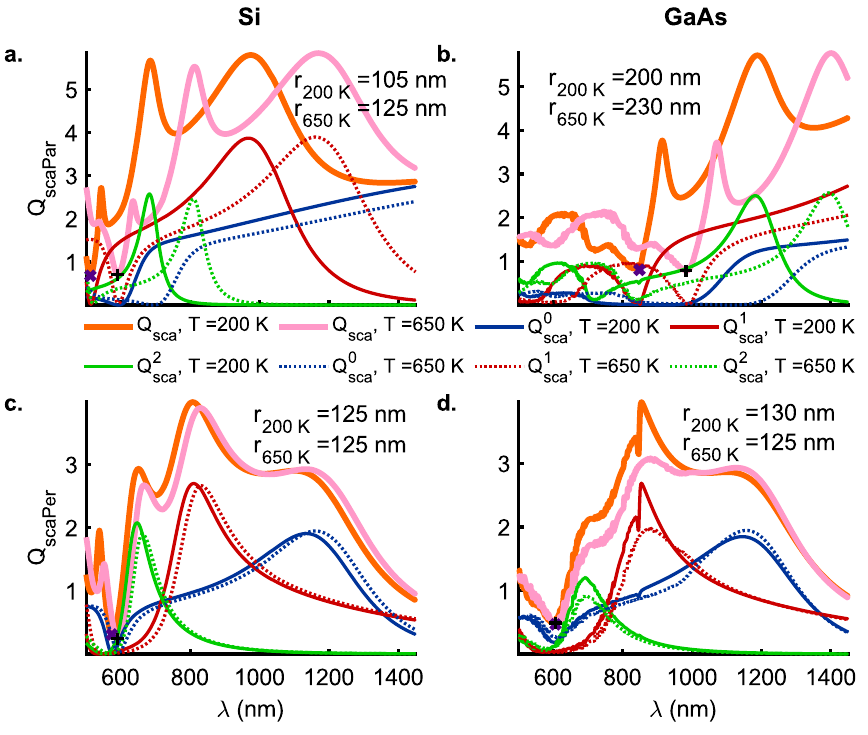
Figure 6. The scattering efficiencies Q sca for the TM ( E ) ( a ) Si, ( b ) GaAs, and, TE ( E ) polarizations ( c ) Si and (cid:31) ⊥ ( d ) GaAs with zeroth (blue), first (red) and second (green) order contributions as a function of the wavelength (cid:31) at temperatures T 200 (solid lines) and 650 (dotted lines) K . The thick orange and pink solid lines represent = 200 and 650 K , respectively. The radii of the nanowires the total scattering efficiencies, Q sca , at temperatures T = min considered here correspond to the global minima shown in Fig. 5 for Q sca as a function of the wavelength of the incident radiation. The purple ( ) and black ( ) markers correspond to the position of the global minima × + in scattering efficiencies for nanowire radii ( r > 50 and 125 nm ) for TM and TE polarizations, respectively (see Fig. 5). Also, see Figs. S1 and S2 for a full color-map of the absoprtion efficiency Q abs for the TM and TE polarizations, respectively, of the incident radiation for Au, Si and GaAs nanowires as a function of the 200 , 470 and 650 K wavelength (cid:31) and radii r at temperatures T =